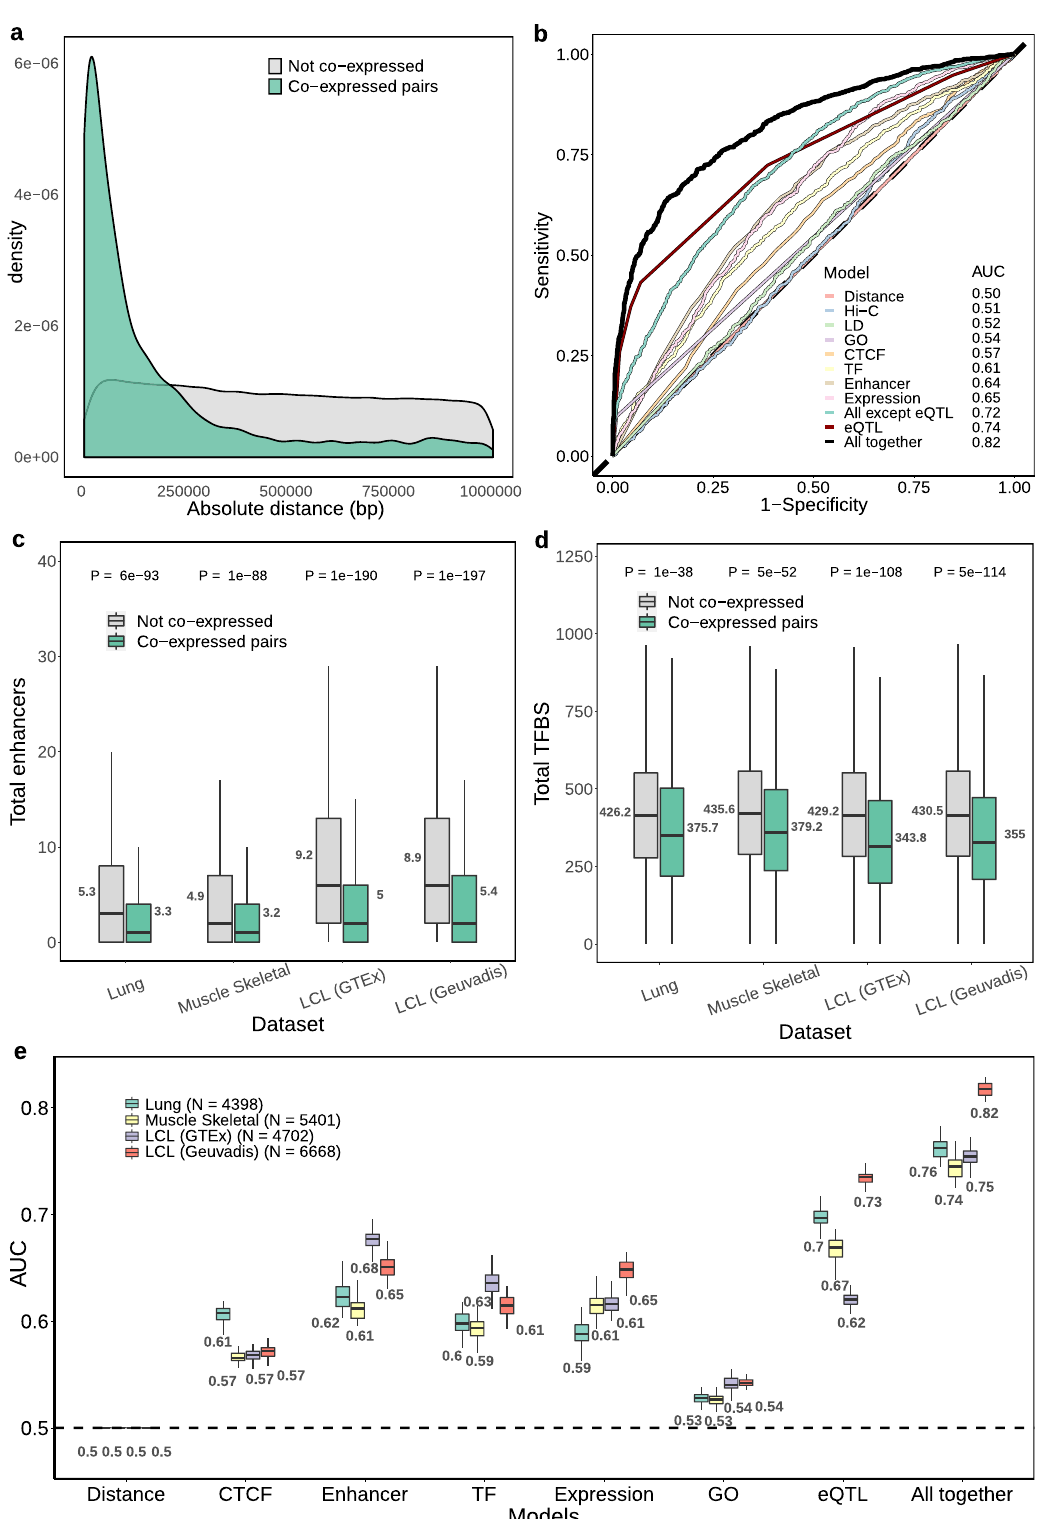
Fig. 3 Molecular features of COPs. a Distribution of the absolute distance between TSS for Geuvadis LCL COPs and non-COPs. Gene pairs before applying paralog and positive correlation fi lters. b Receiver operating characteristic (ROC) curve of predicting Geuvadis LCLs COPs for several molecular features (logistic regression; N = 6668 for COPs and for non-COPs; see the “ Methods ” section for molecular feature descriptions). c and d boxplots of total enhancers and total transcription factor binding sites (TFBS), respectively, between COPs and non-COPs across four datasets: Geuvadis LCLs ( N = 6668), GTEx LCLs ( N = 4702), Lung ( N = 4398) and Muscle Skeletal ( N = 5401). Values next to the boxplots represent the mean. P -values were obtained from two-tailed Wilcoxon signed-rank tests. e Boxplots of the AUC values obtained for each molecular feature and dataset across the 50 training-test set randomisations. Values below each boxplot represent the mean AUC. For each boxplot, the length of the box corresponds to the interquartile range (IQR) with the centre line corresponding to the median, the upper and lower whiskers represent the largest or lowest value no further than 1.5 * IQR from the third and fi rst quartile, respectively. NATURE COMMUNICATIONS| (2021) 12:4842